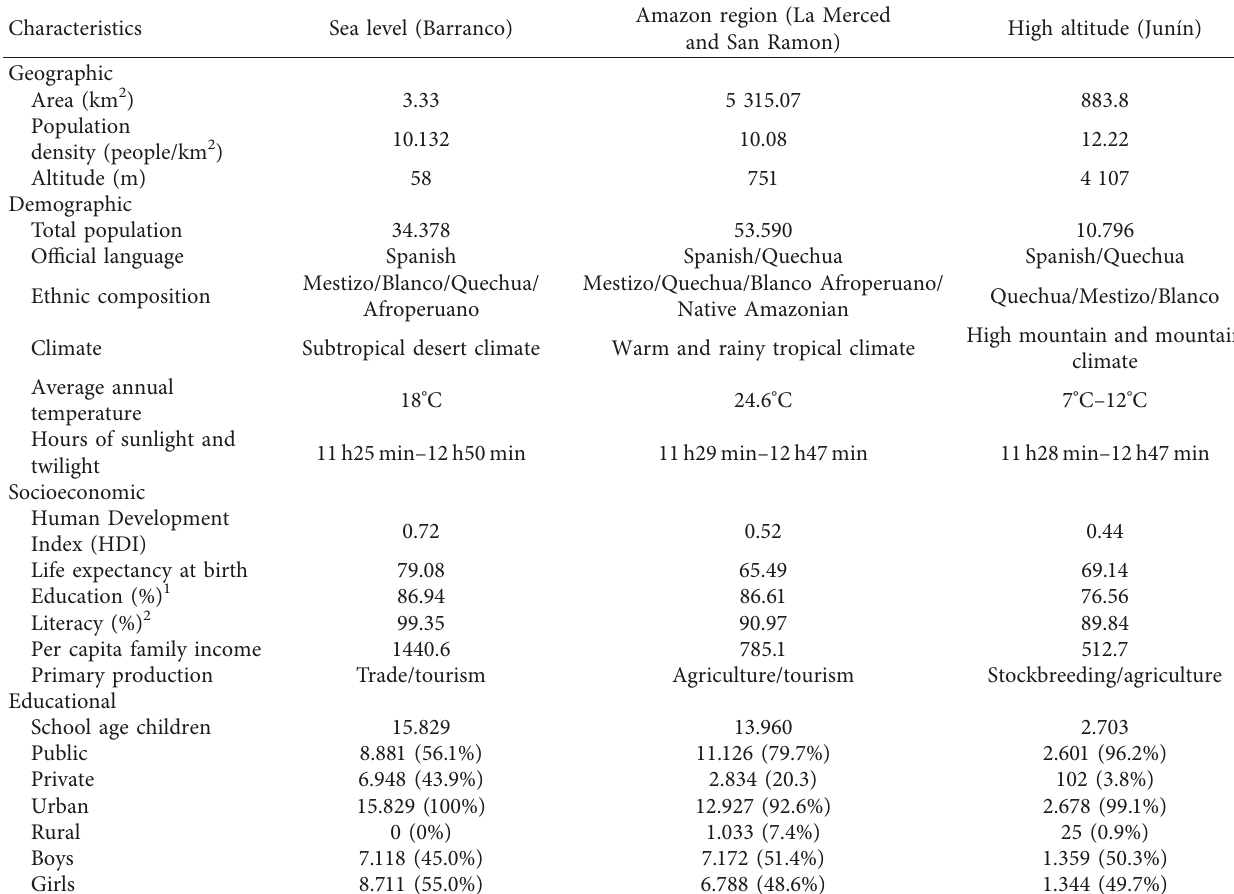
Table 1: Geographic, demographic, socioeconomic, and educational characteristics of the three geographical areas located in the central region of Peru.